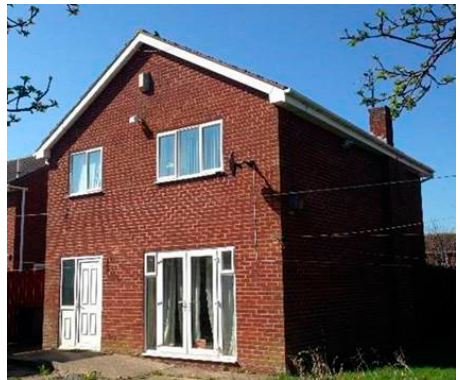
Figure 1. The selected case-study house in Newcastle, UK.